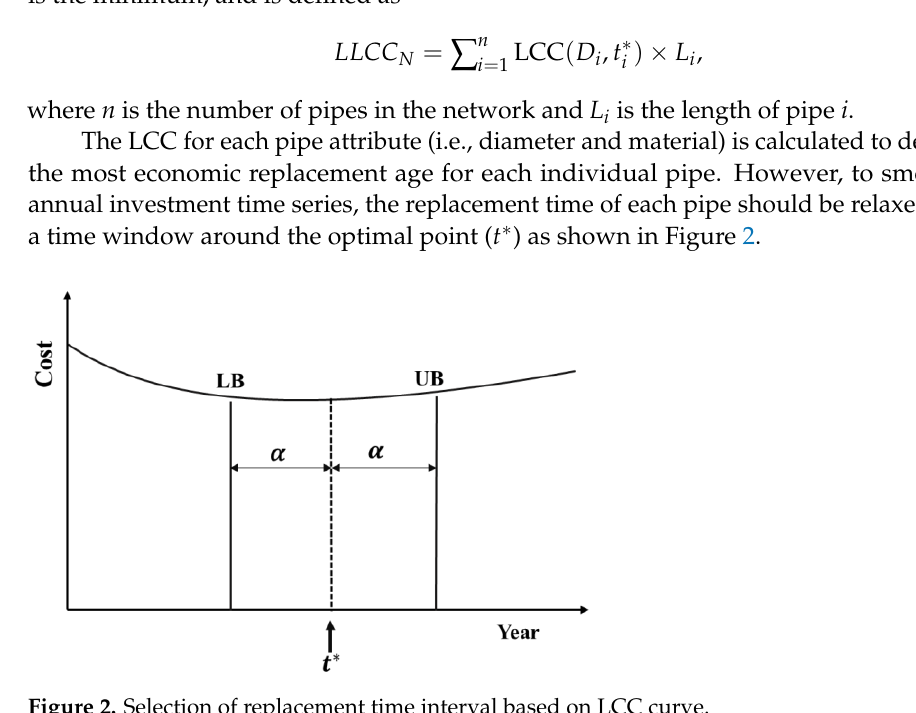
Figure 2. Selection of replacement time interval based on LCC curve.